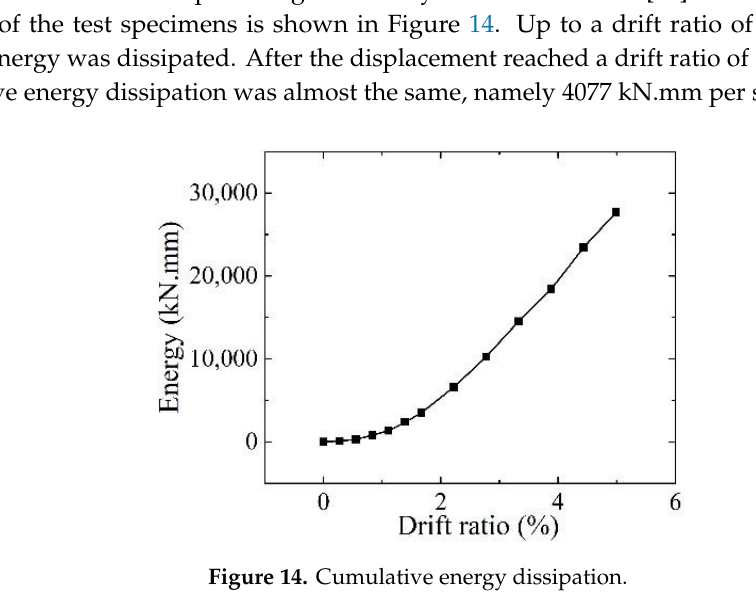
Figure 13. Load-displacement hysteretic curve.